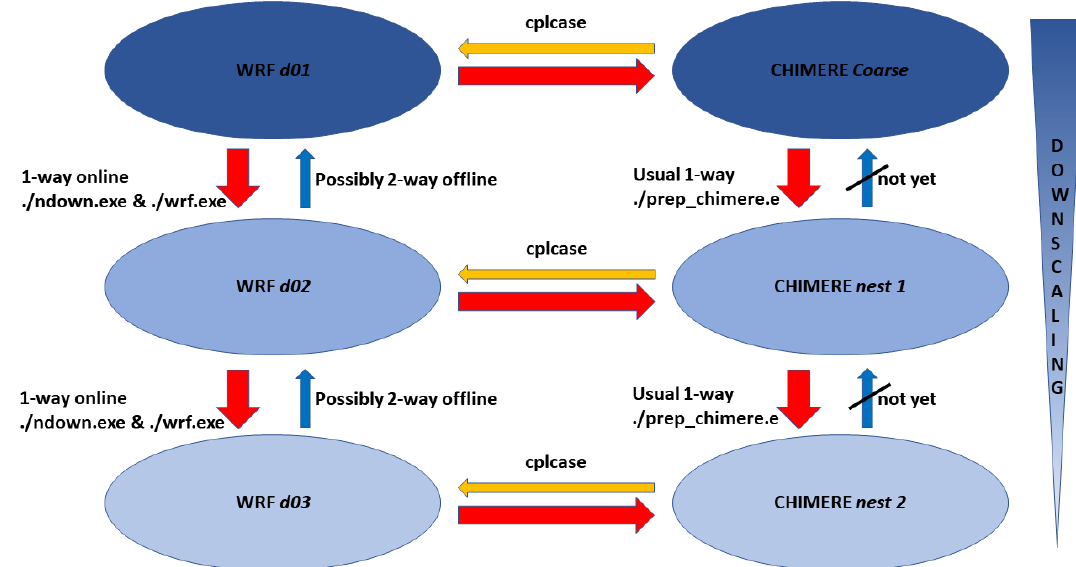
Figure 15. Principle of the nesting in the case of offline or online coupling.